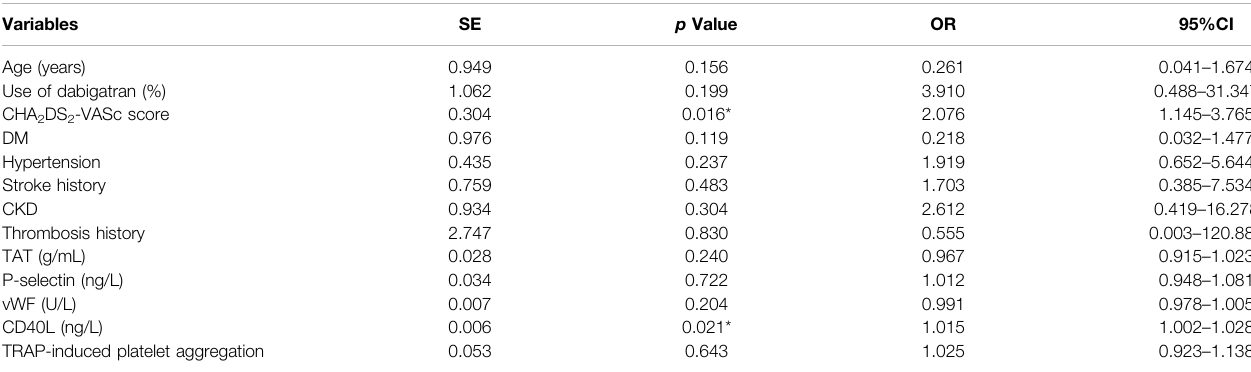
TABLE 4 | Multivariate logistic regression of D-dimer > 0.5 mg/ml after 3-month anticoagulation following